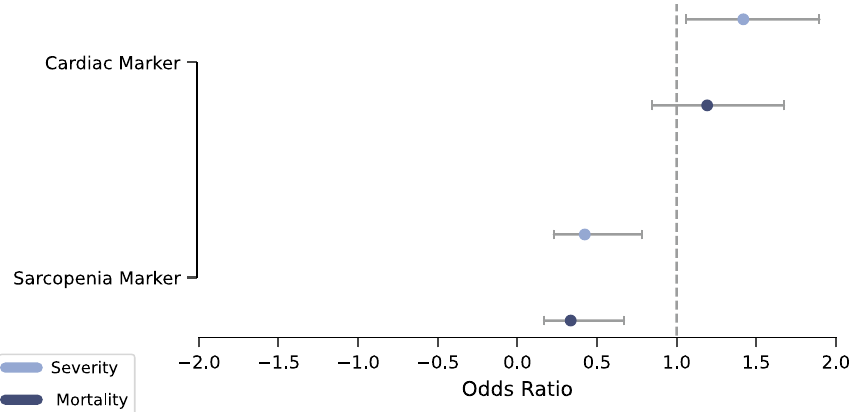
Figure 4. Odds ratio plot for the multivariate logistic regression conducted for both endpoints. The horizontal line is set to an odds ratio of 1, and the odds ratios are displayed with circles. Additionally, the confidence intervals (CI 5%, CI 95%) are presented with the left bars (5%) and right bars